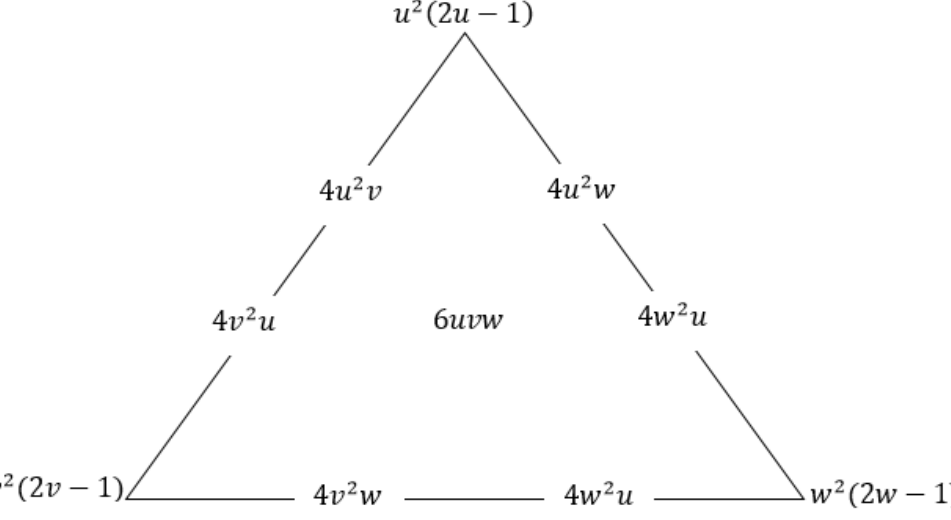
Figure 3. Cubic Timmer triangular bases.